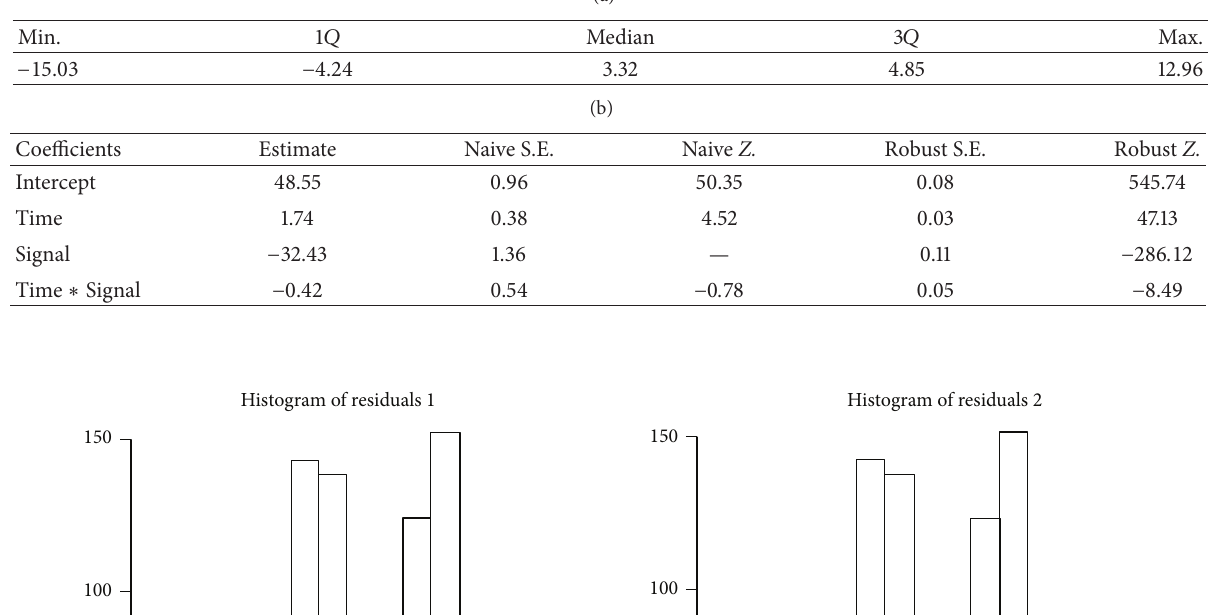
Table 5: The residuals and coefficients for marginal model.